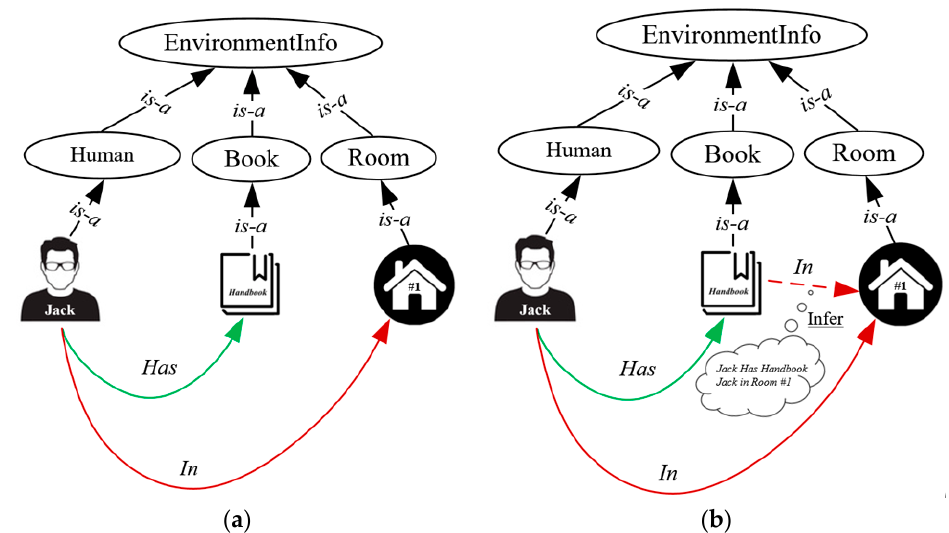
Figure 11. Example of knowledge reasoning. ( a ) Left: the handbook is asserted to be just a book, and Jack has it. ( b ) Right: If some rule knowledge is added, the knowledge system can infer the location of the handbook.